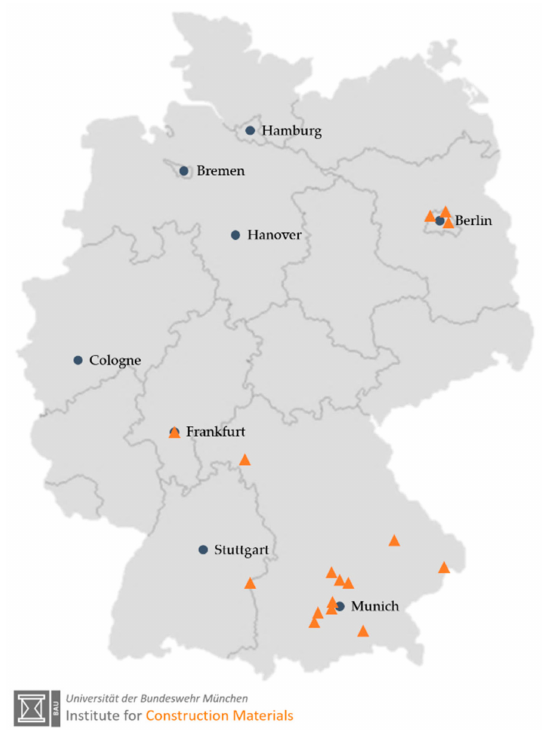
Figure 13. Map of Germany showing locations where ILC-projects have been realized until end